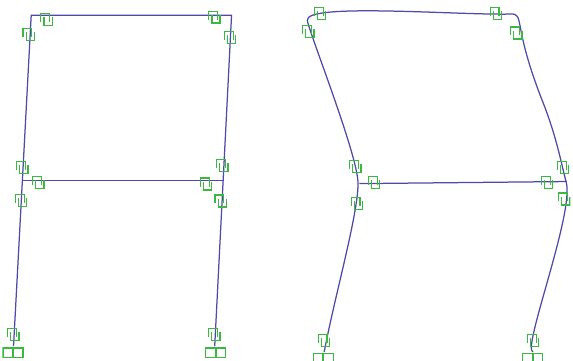
Figure 7: The first (left) and second mode shapes of the two-storey